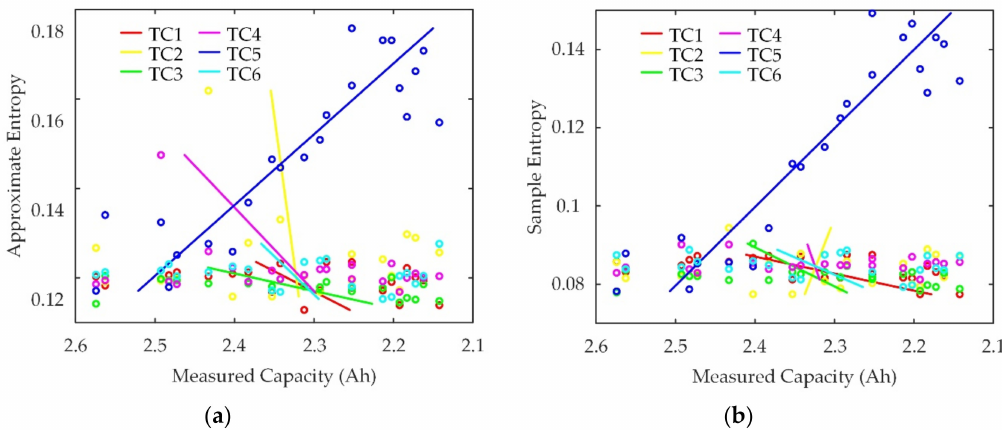
Figure 12. First-order curving fitting result. ( a ) Approximate entropy-based method; ( b ) Sample entropy-based